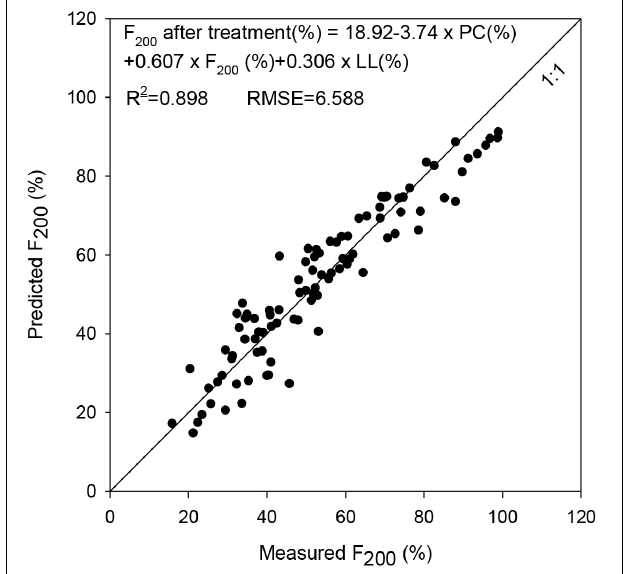
FIGURE 3 | Comparison of measured F 200 and predicted F 200 of the cement treated soils.